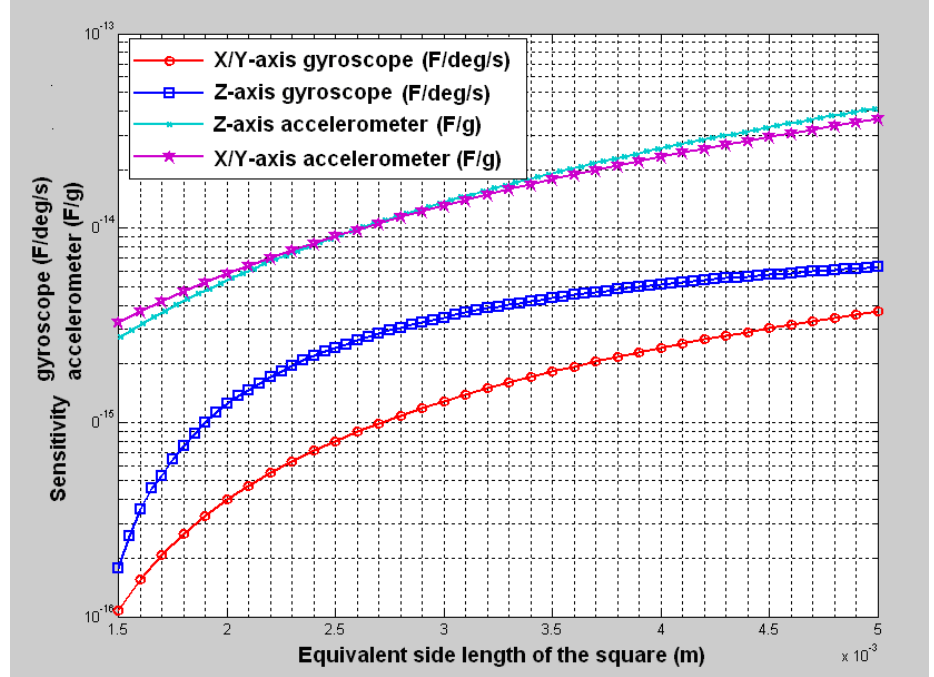
Figure 6. The sensitivity versus layout area; the natural frequency of each inertial sensor is chosen as 4,000 Hz.